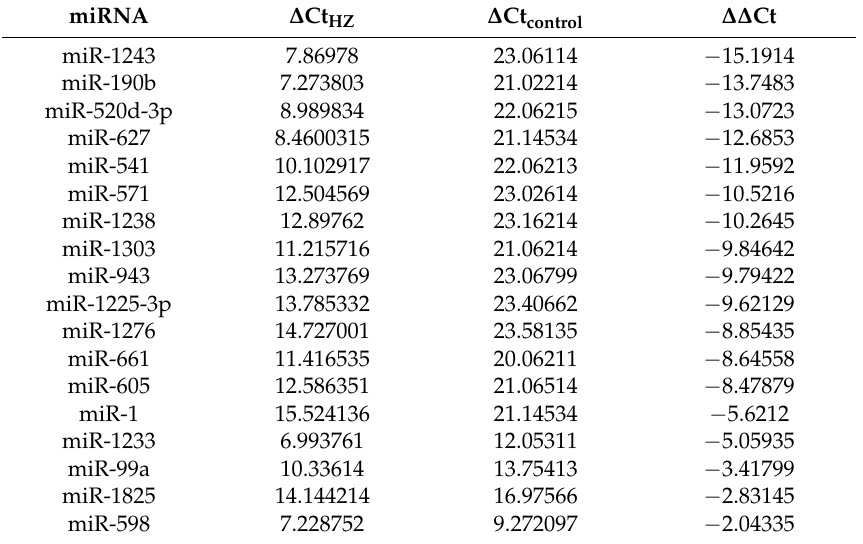
Table 2. Up-regulated microRNAs (miRNAs) in HZ patients, compared with controls, using a TaqMan low density array (TLDA). miRNA ∆ Ct HZ ∆ Ct control ∆∆